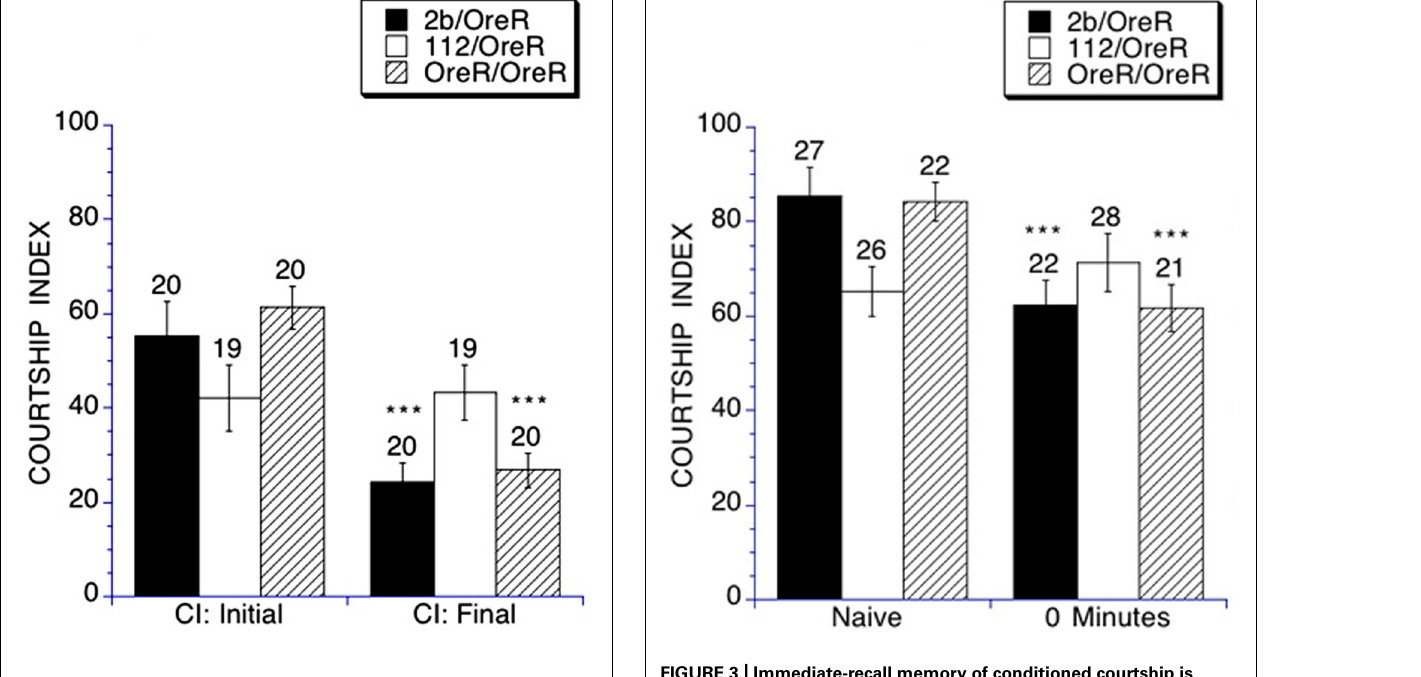
FIGURE 2 |The learning-during-training phase of conditioned courtship is impaired in heterozygous DmGluRA 112 mutant flies. Mean CIs ( ± SEM) are plotted; Ns are indicated above each bar for all groups. For levels of significance, *** p < 0.001.The initial and final courtship levels of control DmGluRA 2b precise excision heterozygous flies (filled black bars), DmGluRA 112 heterozygous mutant flies (open bars) and OreR background flies (striped bars) are compared. Control DmGluRA 2b flies and control OreR background flies exhibited intact learning-during- training as demonstrated by a significant depression of courtship activity from the initial to the final interval of the training session, whereas heterozygous DmGluRA 112 mutant flies did not demonstrate learning-during-training.